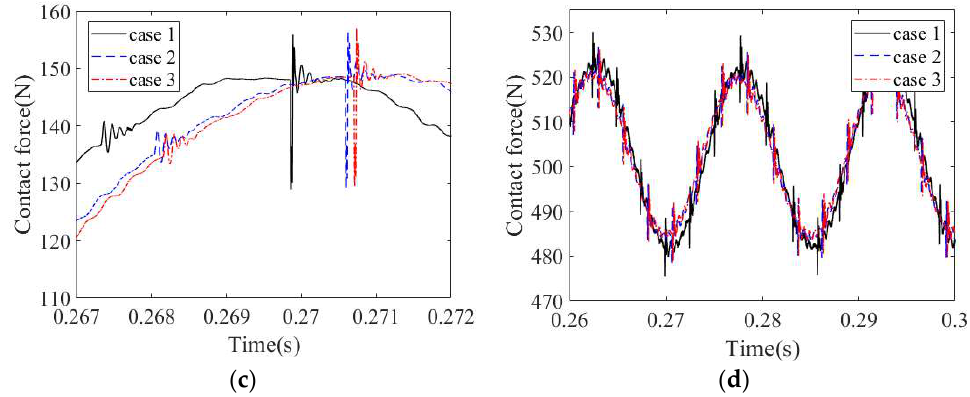
Figure 16. The acceleration signal and forces in the bearing under outer ring defect and housing stiffness: ( a ) housing acceleration signal from 0.267 s to 0.272 s; ( b ) contact force between outer ring and housing from 0.267 s to 0.272 s; ( c ) contact force between the roller and outer ring from 0.267 s to 0.272 s; ( d ) contact force between outer ring and housing from 0.26 s to 0.3 s.